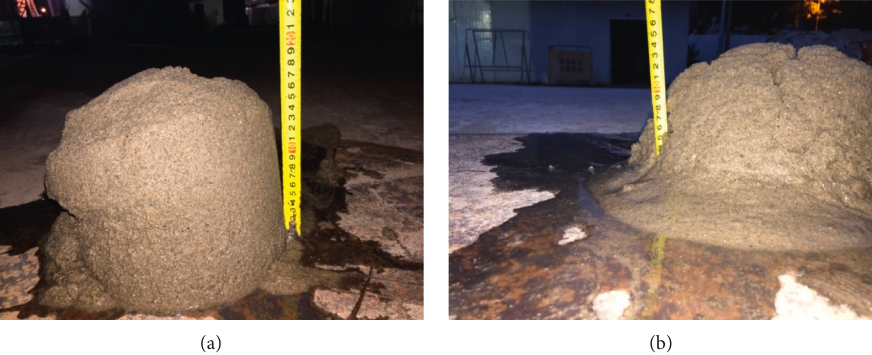
Figure 9: Effect of sodium bentonite-CMC mixed mud and different concentrations of polyacrylamide solution on slump improvement.